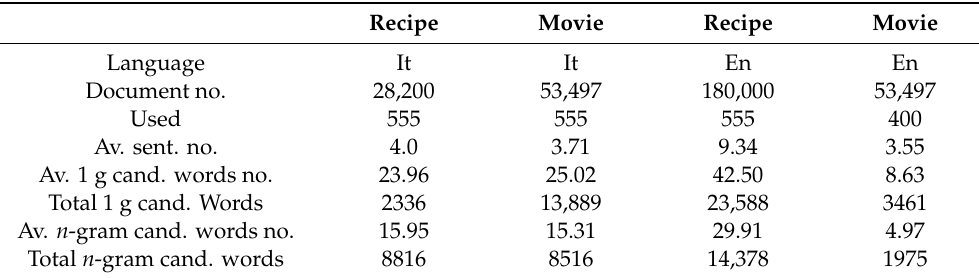
Table 2. Information on the 4 datasets used.